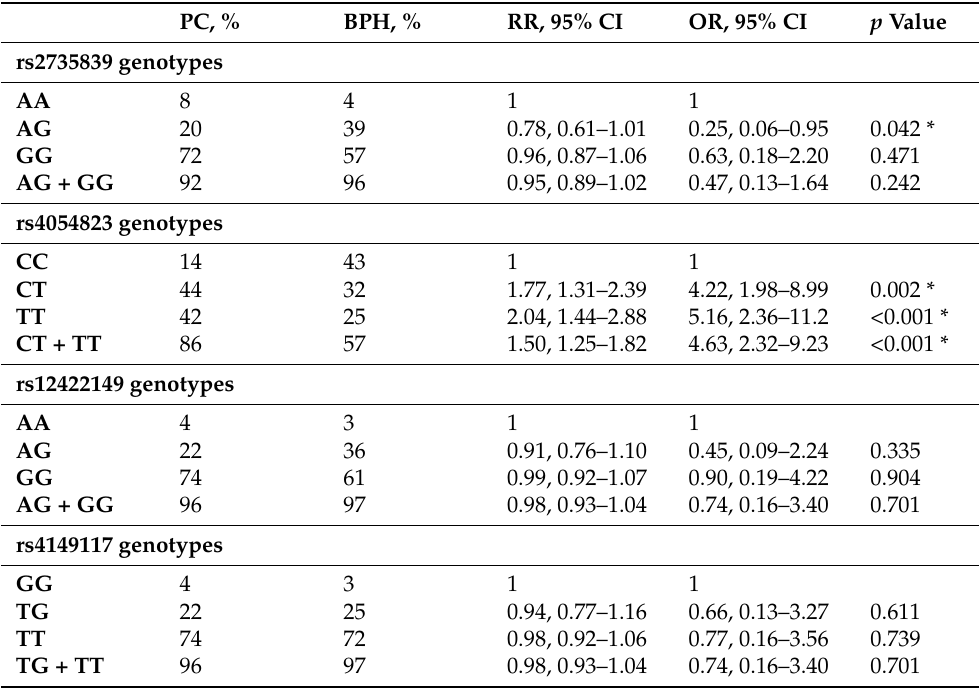
Table 2. Genotype frequency of the analyzed SNPs within the PC and BPH groups.